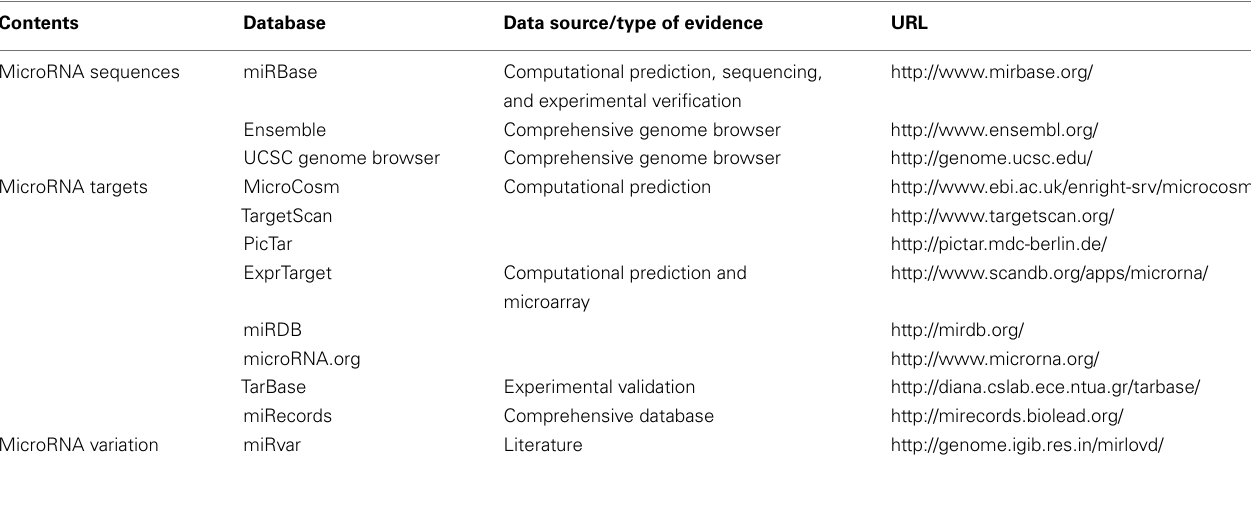
Table 1 | Some widely used bioinformatic resources of microRNA sequences, gene targets and genetic